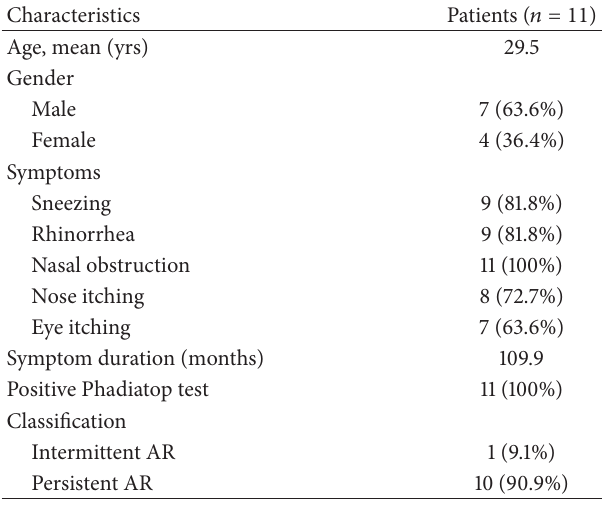
Table 1: Demographic and clinical characteristics of